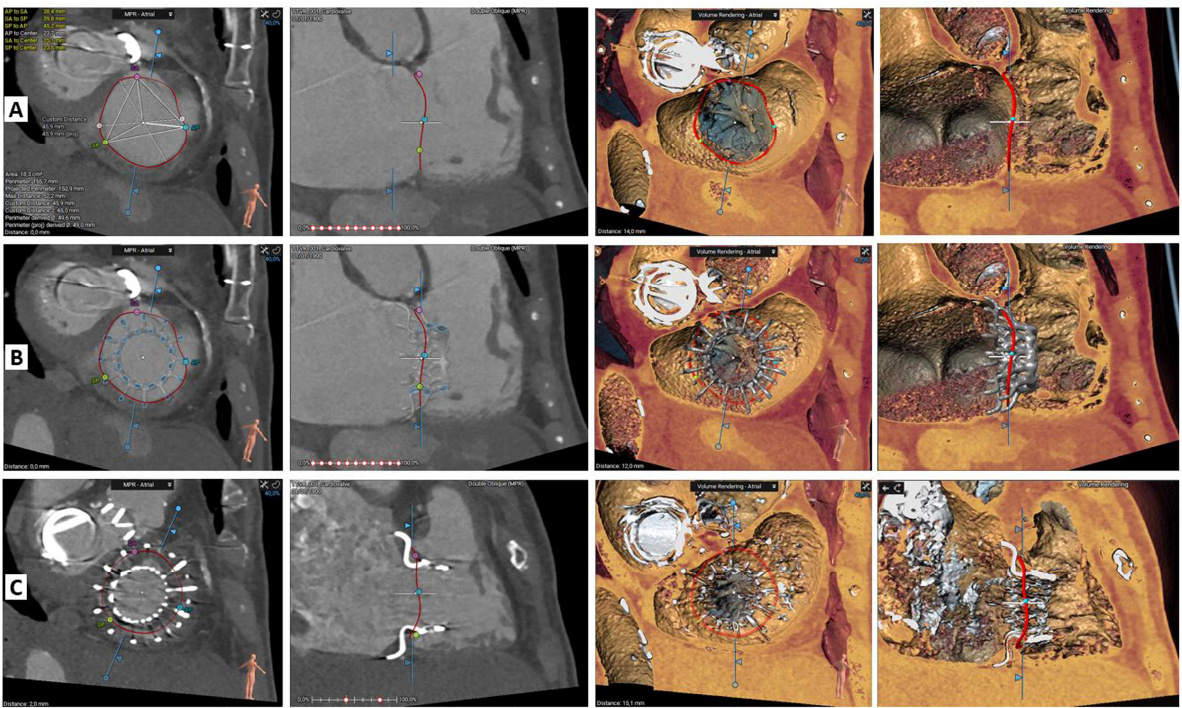
Figure 3. Cardiovalve TTVR case. Computed tomography pre-procedural assessment ( A ), device deployment simulation ( B ), and result after procedure ( C ). Tricuspid annular plane on 2D (first column) and 3D volume rendering (third column). Long-axis right ventricle on 2D (second column) and 3D volume rendering (fourth